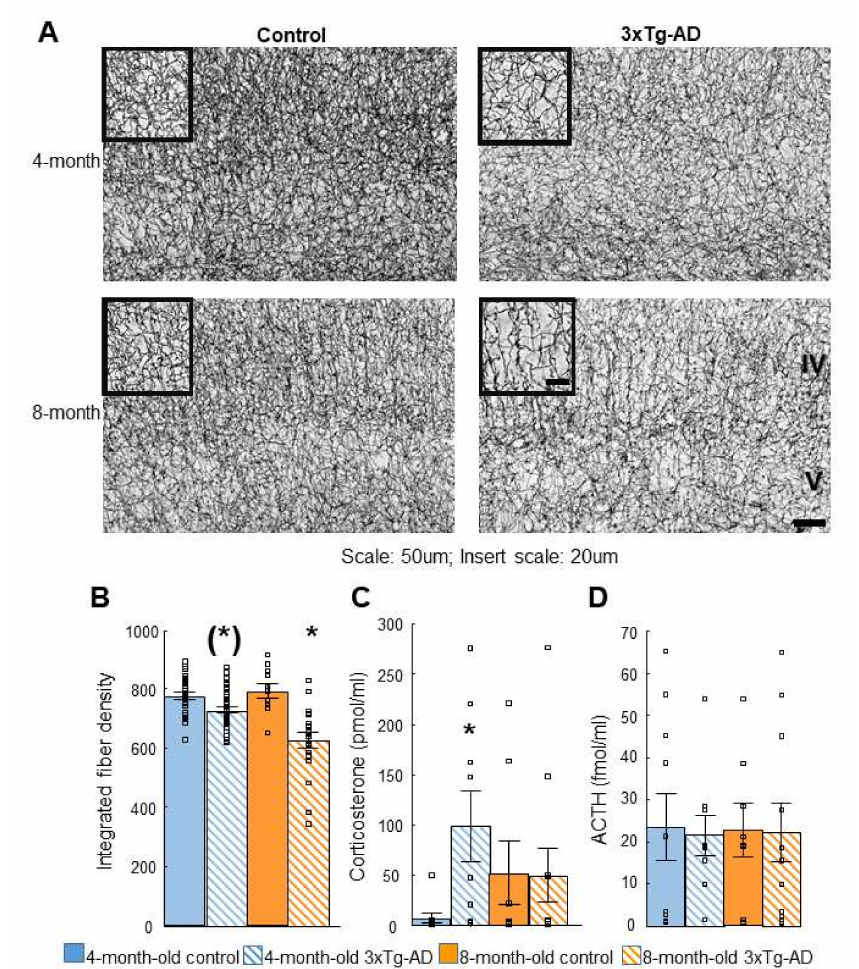
Figure 4. Visual ( A ) and quantitative ( B ) results of the acetylcholinesterase (AChE) immunohisto- chemistry. The integrated fiber density was measured in the same area for each section between the 4th and 5th cortical layers (see Figure 4). Post-hoc analysis showed that in 8-month-old animals the difference was more pronounced (4-month: * p = 0.02; 8-month: * p = 0.00). ( C ): Elevated corti- costerone levels were measured in 3xTg-AD animals after dexamethasone treatment compared to controls, however, this difference was only significant in 4-month-old animals (* p < 0.05). ( D ): There was no significant difference in adrenocorticotropin (ACTH) levels in either group ( p >